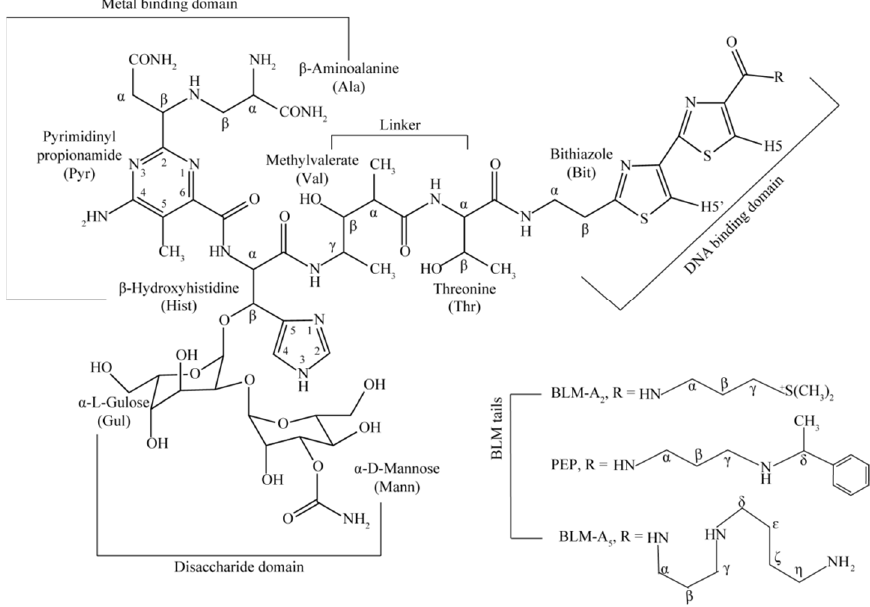
Figure 1. Structures of BLM-A 2 , BLM-A 5 , and PEP. BLM, bleomycin; PEP, peplomycin.